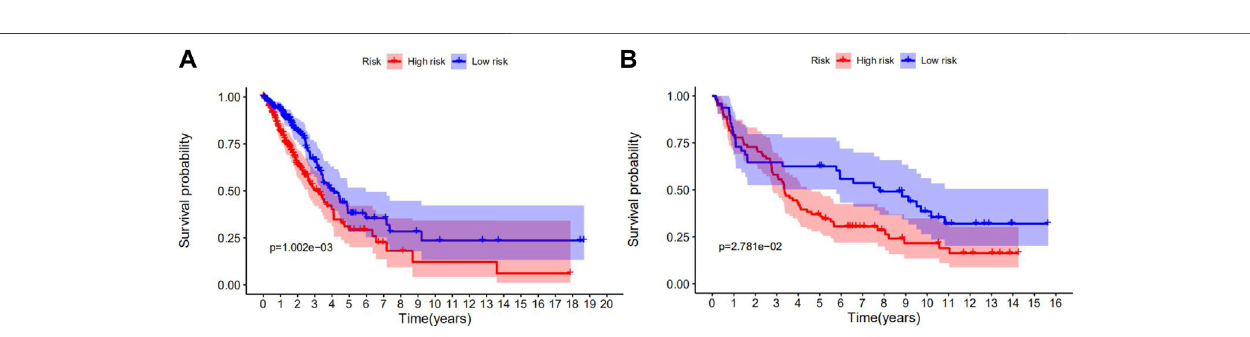
FIGURE 3 | Survival analyses of the prognostic ferroptosis-related genes in NSCLC using the Kaplan-Meier method. (A) The Kaplan-Meier curve of TCGA cohort. (B) The Kaplan-Meier curve of the GEO cohort. p -values < 0.05 indicate that the OS differed signi fi cantly between high- and low-risk patients.